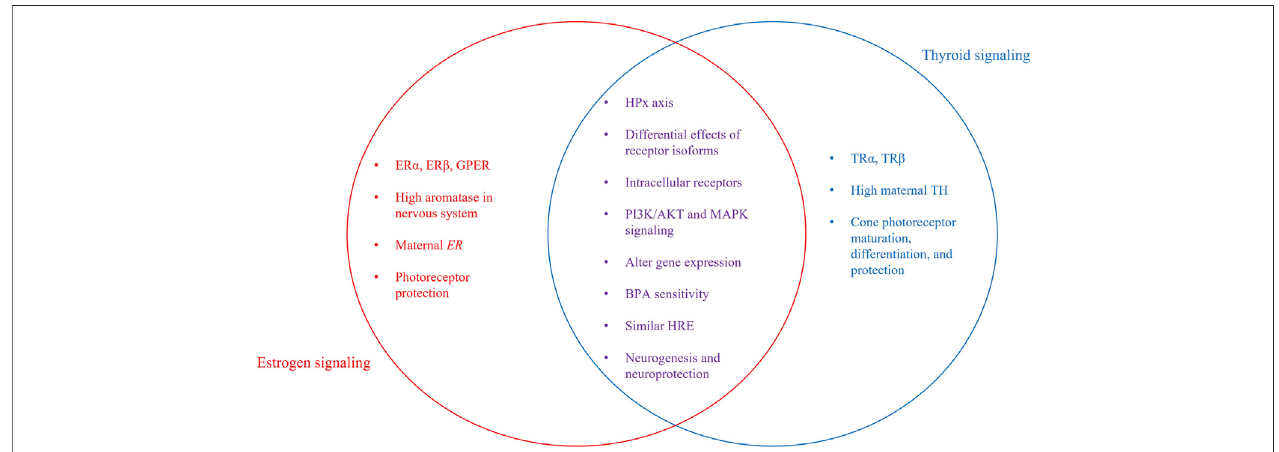
FIGURE2| Independentandinteractivepathwaycomponents.VennDiagramshowingindividualandinteractiveaspectsofestrogenandthyroidsignaling.Shared characteristics between both signaling pathways include the involvement of the hypothalamus-pituitary axis, intracellular receptors, some intracellular signaling molecules, and effects on gene transcription. Both E2 and TH are required for neurogenesis, including development of the visual system. Photoreceptors are the retinal cell type most sensitive, as TH is required for correct development and organization of cones. E2 is neuroprotective, preventing cell loss due to light-damage or